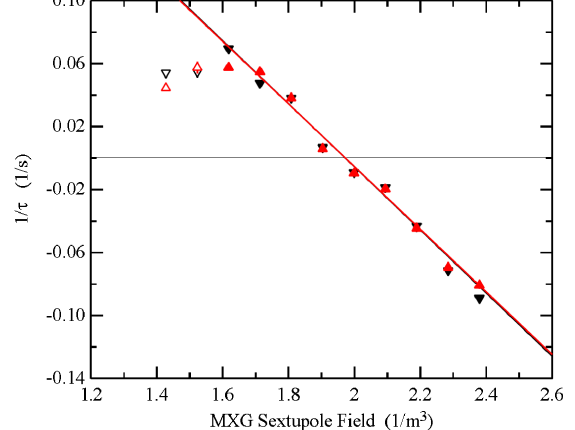
FIG. 15. 1 / τ points for the wide beam scan 1 as a function of the G sextupole field ( S is zero). The black triangles are for the down polarization state and the red triangles are for the up polarization state. The filled symbols indicate those points included in the straight line fit. Points shown with open symbols were not included. Weights based on the statistical errors were used. This emphasizes points in the fit that are near the zero crossing.